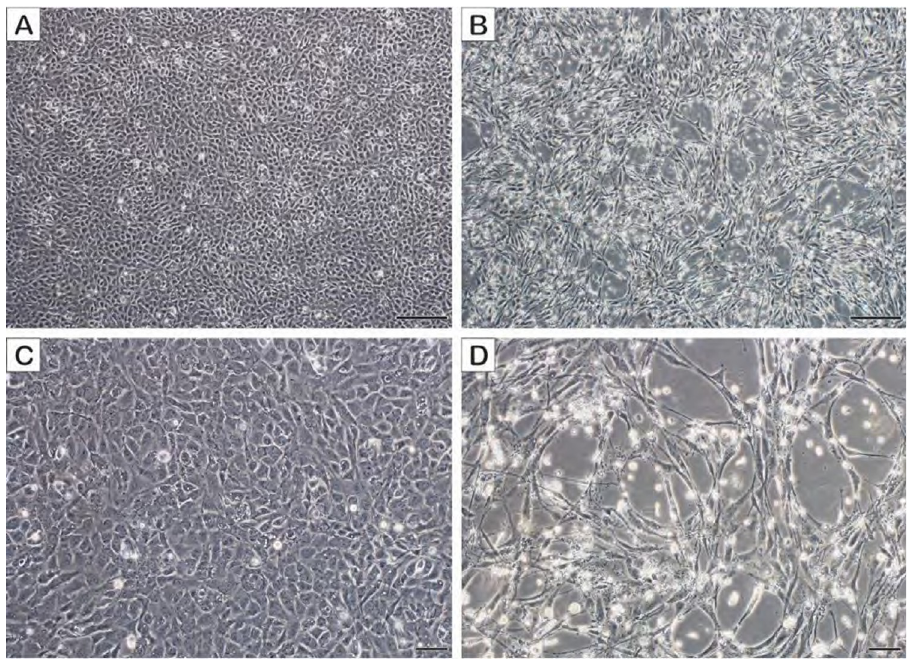
Fig 6. In vitro growth characteristics of the Turtle fraservirus 1 in Terrapene heart (TH-1) cells (viral passage 2). A) and C) uninfected TH-1 cells, 8 days post-inoculation (dpi). B) and D) appearance of plaques within the TH-1 monolayer 8 dpi. Affected cells appear refractile and either elongated and spindly or rounded. Scale bars in A and B = 200 μ m, C and D = 50 μ